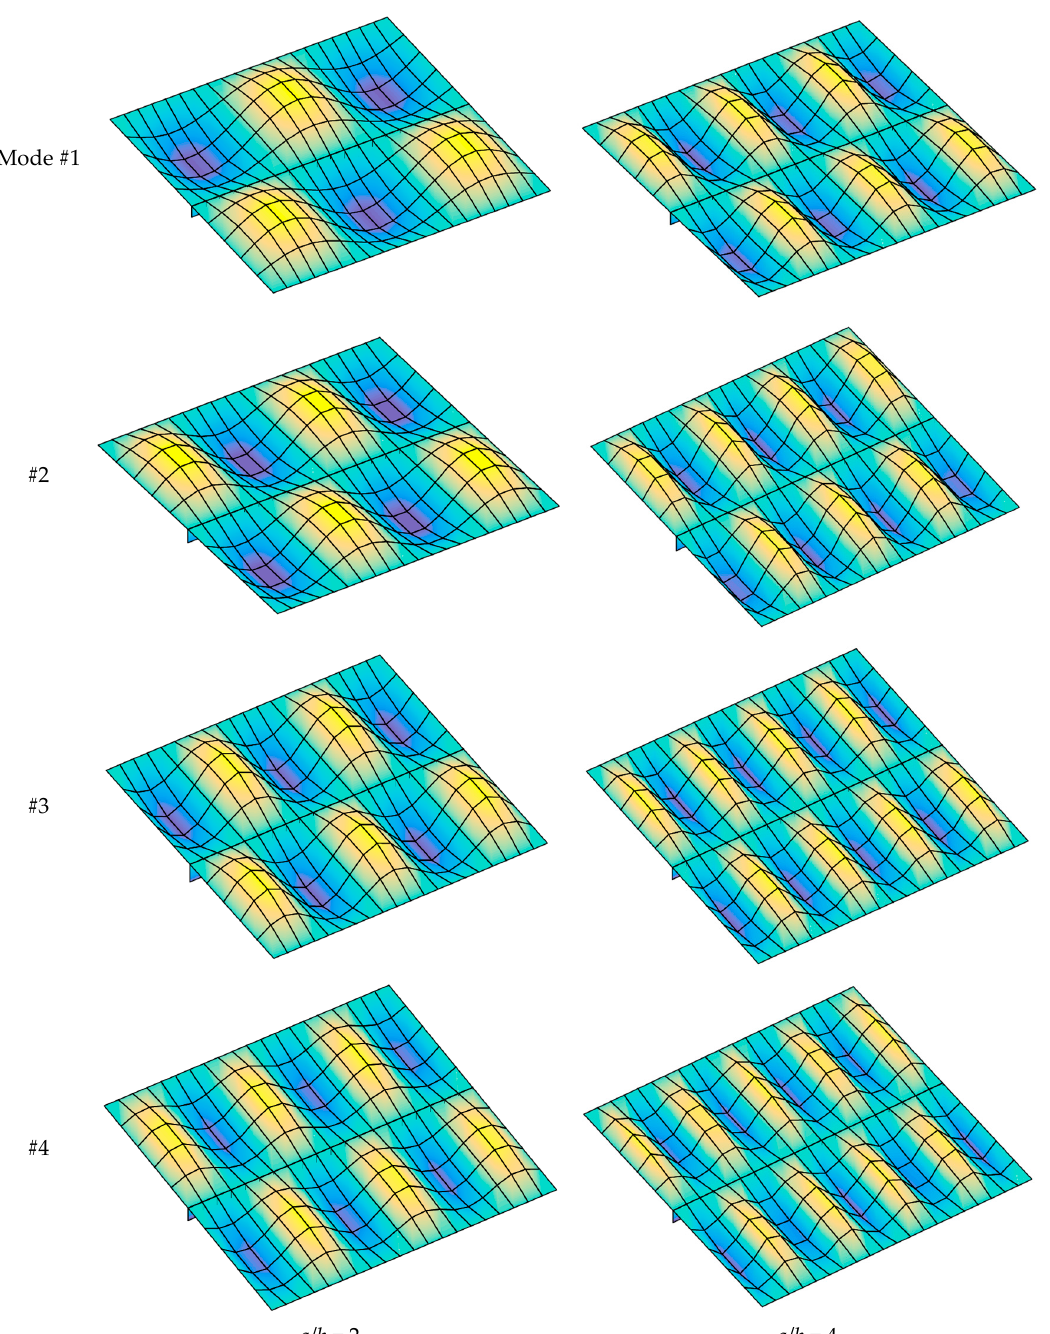
Figure 9. The first four buckling mode shape of stiffened FGM plate ( b / h = 10, n = 0.5, Si 3 N 4 /SUS304).